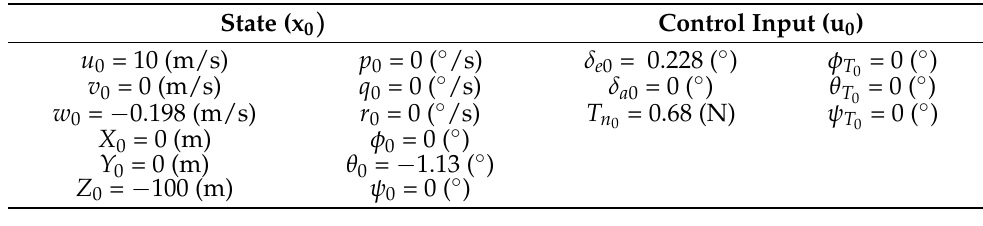
Table 3. Aircraft initial state and control inputs at steady cruise trim